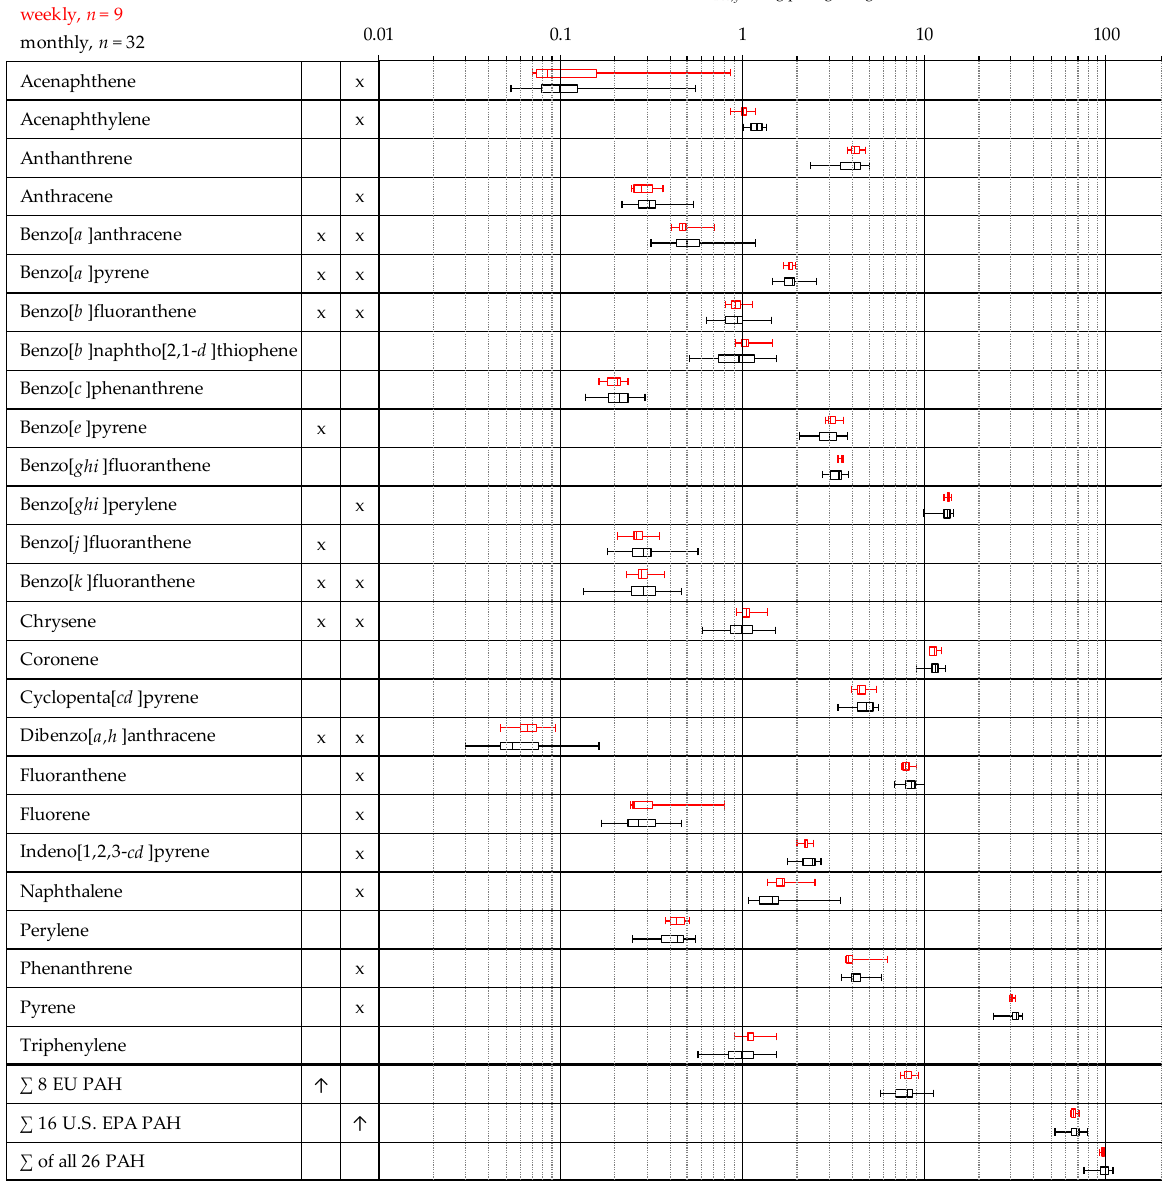
Figure 4. Overview of the measurement data distribution of the entire measurement series for weekly and monthly mixed samples from whole passenger car tires in the form of a boxplot (see Section 3.1.).